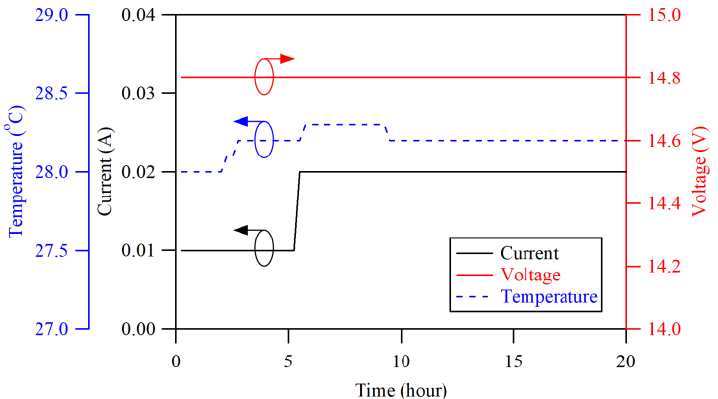
Figure 5. Scenario one: charging profile of failed batteries that did not accept charge when being charged at 14.8 V. charged at 14.8 V.